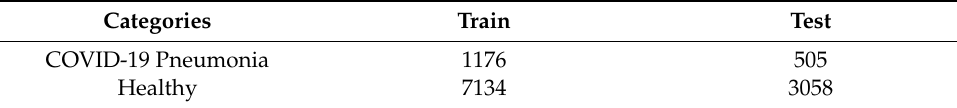
Table 1. Dataset Split for COVID-19 CXR Model (70:30 Ratio).